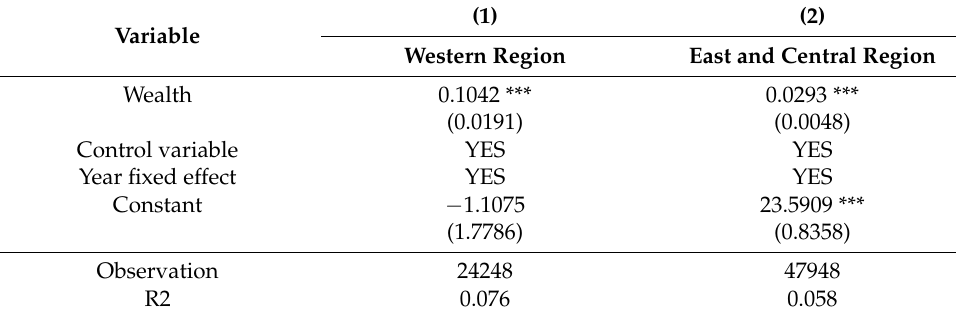
Table 6. Heterogenous effect with respect to